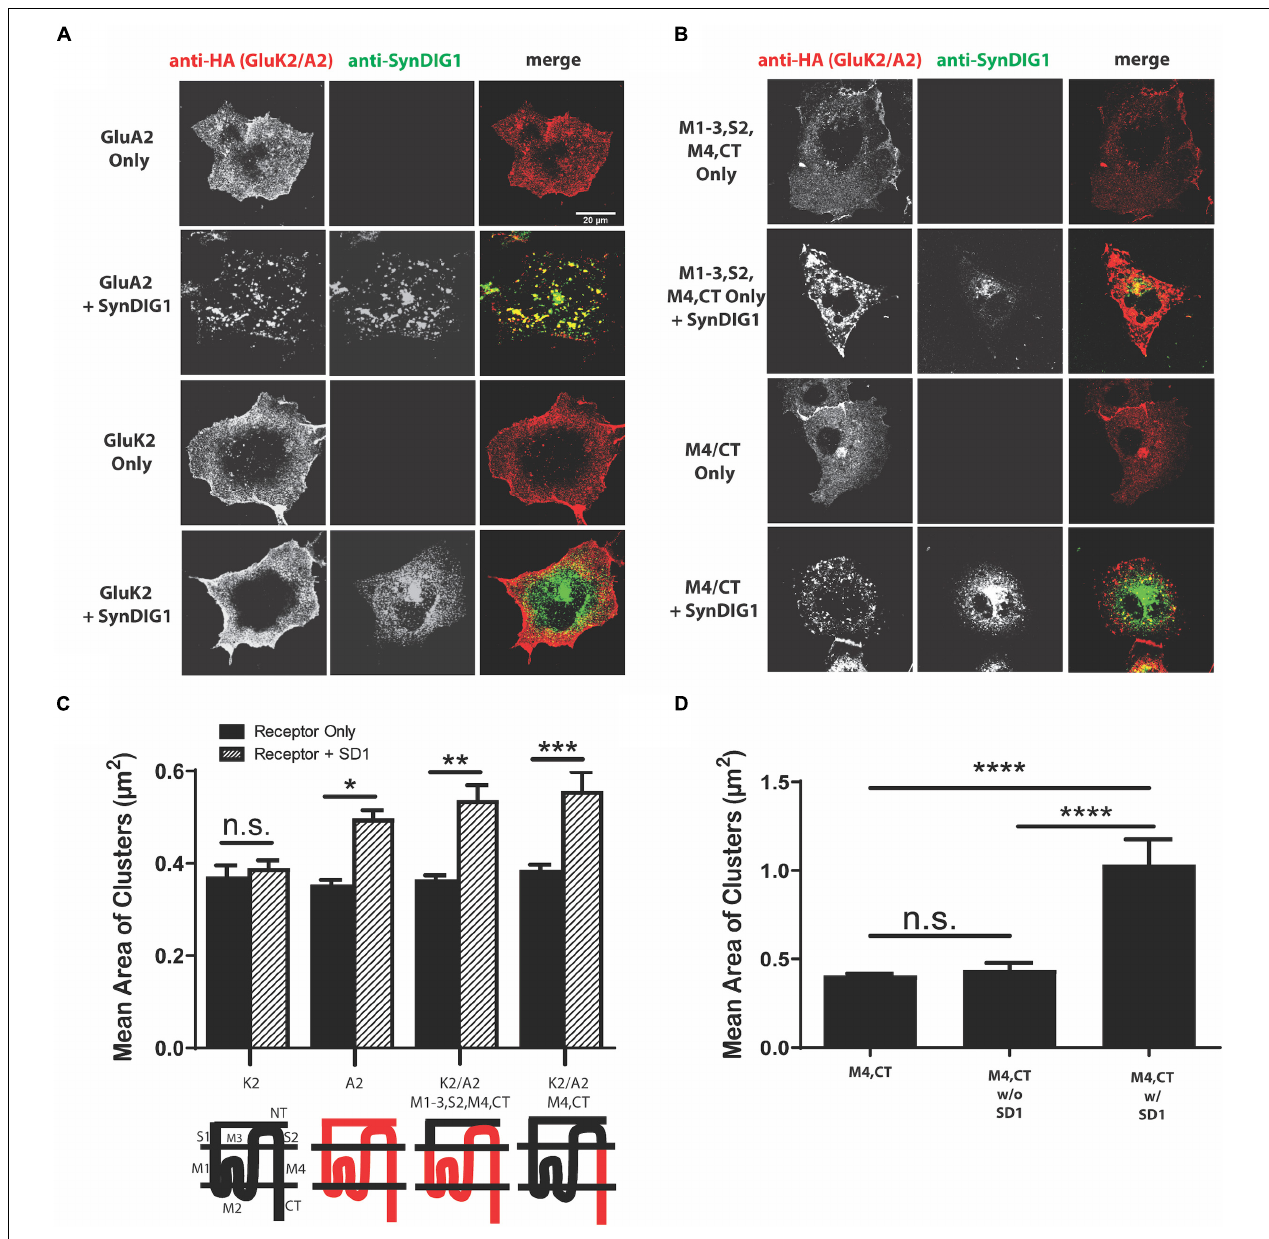
FIGURE 5 | The M4 and C-terminus of GluA2 is sufficient for clustering with synapse differentiation-induced Gene 1 (SD1). (A) Representative confocal images of COS cells transfected with GluA2 alone, GluK2 alone, or co-transfected with GluA2 or GluK2 and SD1. Scale bar = 20 µ m. (B) Representative confocal images of chimeras expressing the M1-3, S2, M4, CT and M4, CT domains of GluA2 either alone or co-expressed with SD1. Scale bar = 20 µ m. (C) Graph depicts the mean area of clusters when GluK2, GluA2, and each GluK2/A2 chimera is expressed either alone or co-expressed with SD1. (D) Graph depicts the mean area of M4, CT chimera clusters stratified for either co-localized or non-colocalized with SD1. M4, CT alone ( n = 13), M4, CT w/o SD1 ( n = 13), M4, CT w/ SD1 ( n = 11). Data are represented as mean ± SEM; n.s. not significant; * p < 0.05; ** p < 0.01; *** p < 0.001; **** p < 0.0001; one-way ANOVA with post-hoc Tukey’s